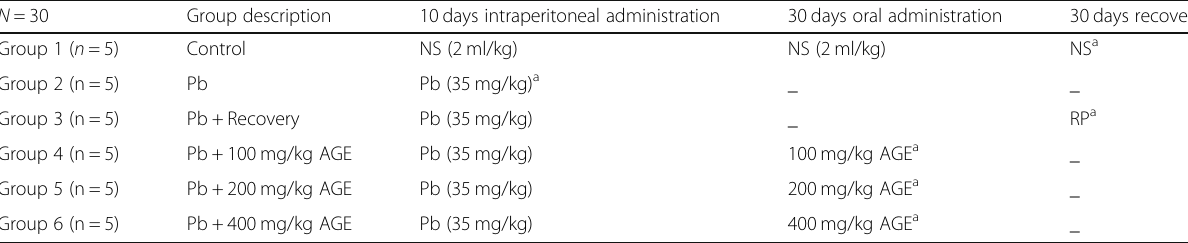
Table 1 Experimental protocol and dose